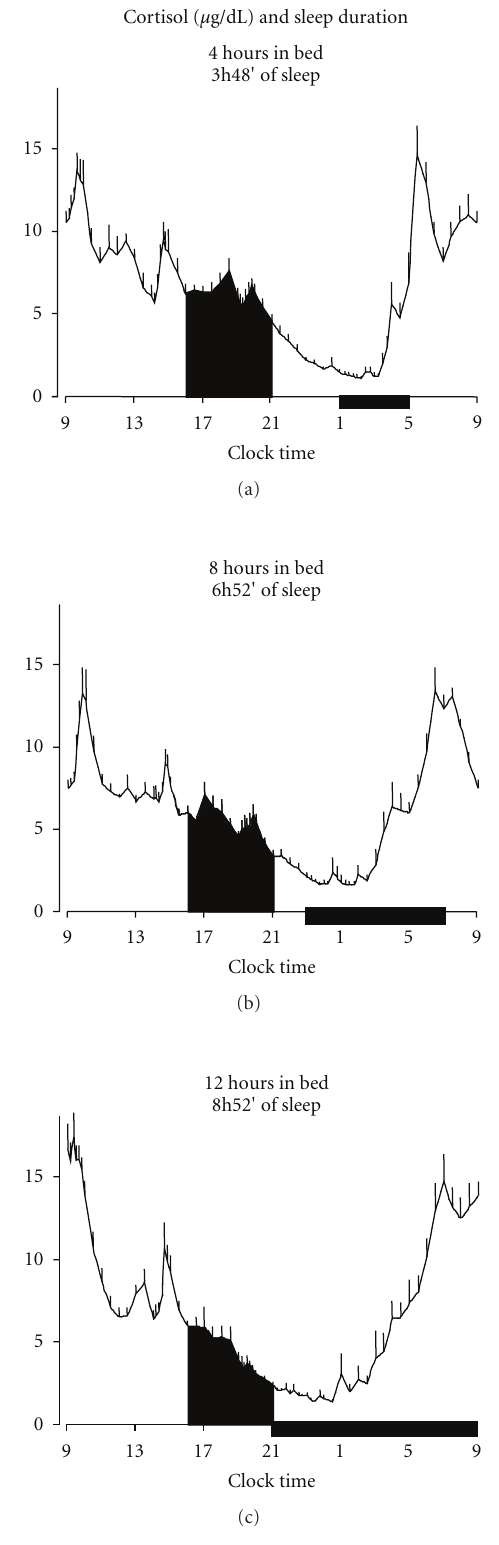
Figure 5: Inverse “dose-response” relationship between evening cortisol levels and sleep duration. Mean 24-hour (+ SEM) cortisol profiles and AUC (black areas) under 4 hours, 8 hours, and 12 hours bedtimes. Black bars represent the sleep periods. (Adapted from Spiegel et al.